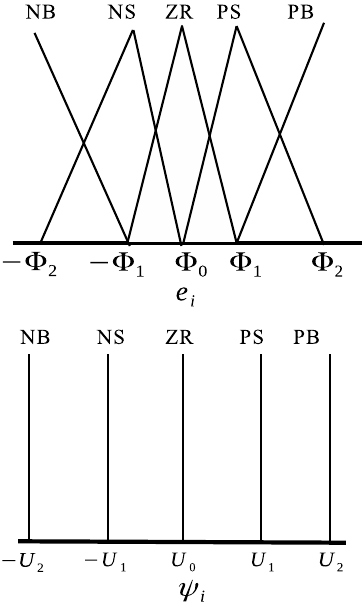
Figure 2. Membership functions for the input e i and the output ψ i